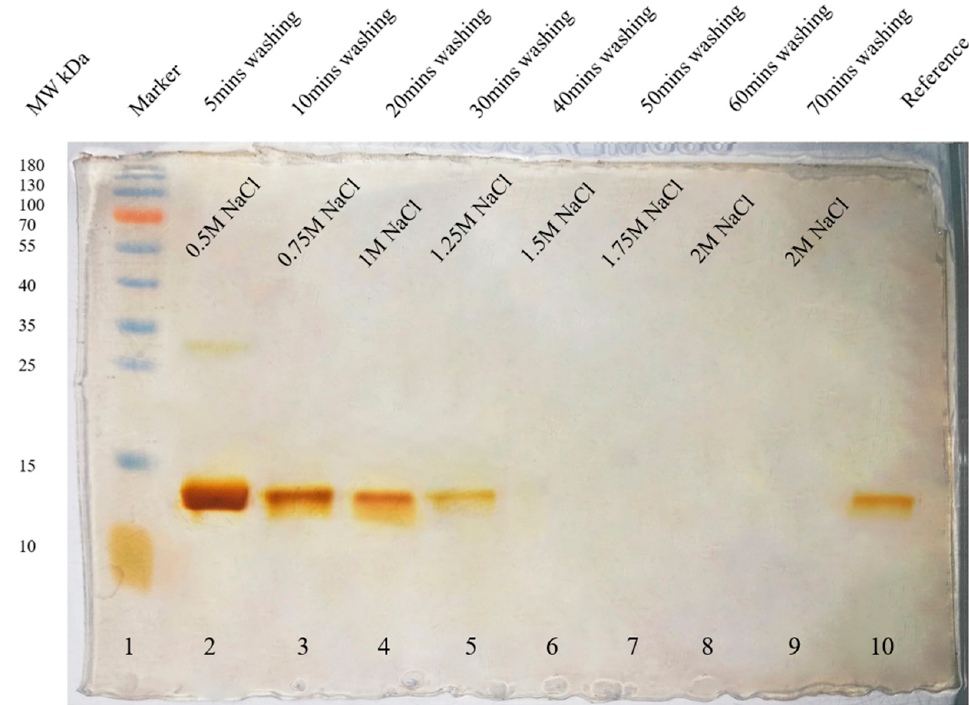
Figure A10. Color image of SDS PAGE gel (uncropped).